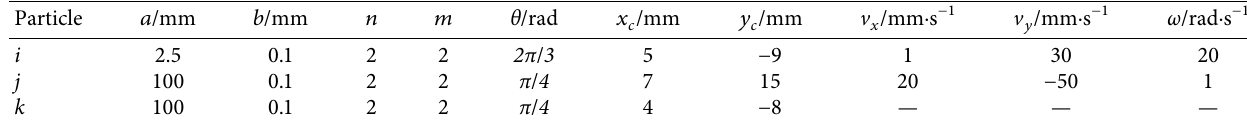
Table 3: Parameters of ellipses.